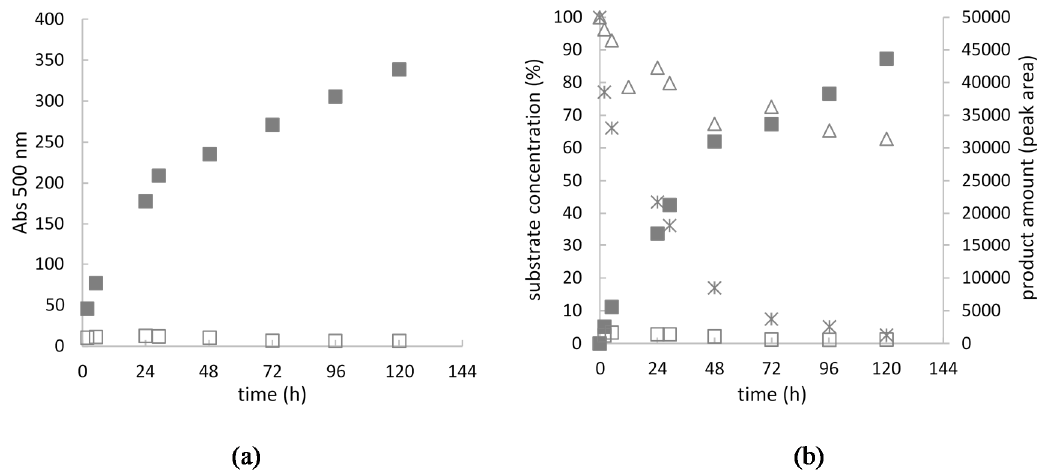
Figure 5. Amount of AB2 dye obtained from substrate A and B2 equimolar oxidation (total concentration of mixture 5 g/L) using fungal LAC (200 U/g) during 5 days of transformation. The amount of the dye was expressed as total absorbance at 500 nm ( a ) and AB2 dye peak area obtained from HPLC analysis ( b ) of water and methanol fractions. Residual concentration of A and B2 substrates (%) was analysed using HPLC. Substrates and products are marked as follows: AB2 dye fraction dissolved in water – empty square; AB2 dye fraction dissolved in methanol – filled square; substrate A residual concentration (%) – cross; substrate B2 residual concentration (%) – triangle.